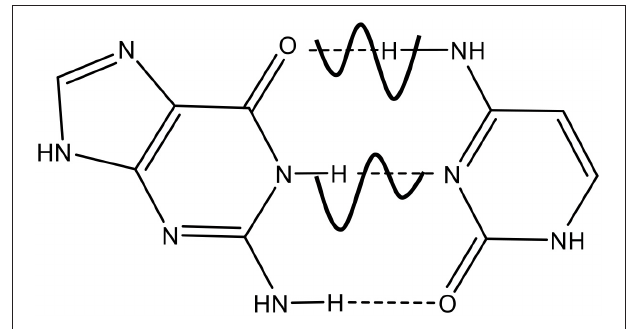
FIGURE 1 | G-C → G* − C *: DPT in the double potential wells.